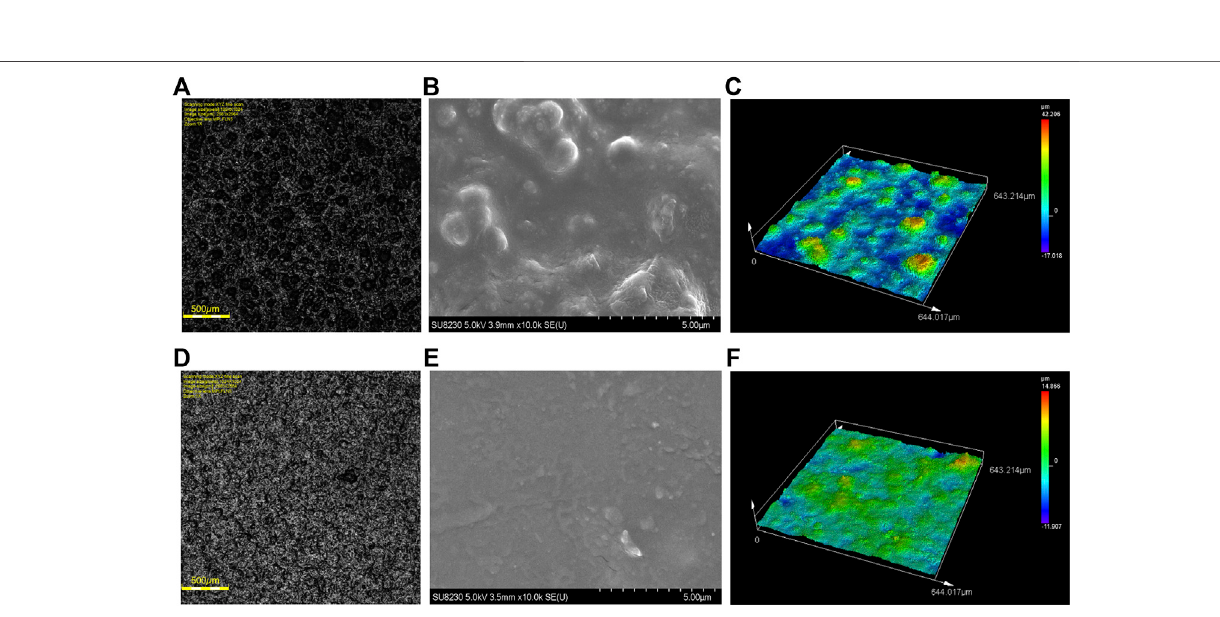
Frontiers in Materials |